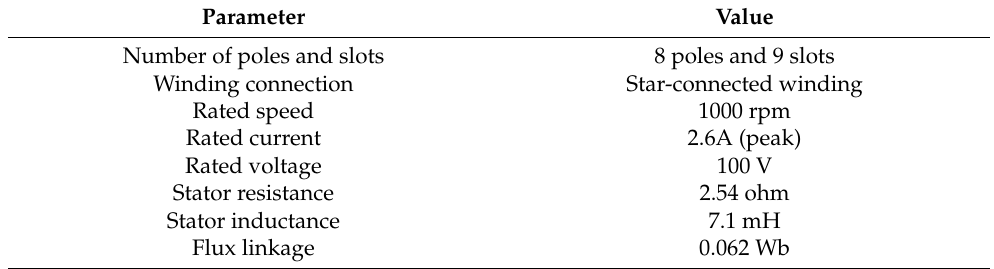
Table 1. Tested PMSM parameters.